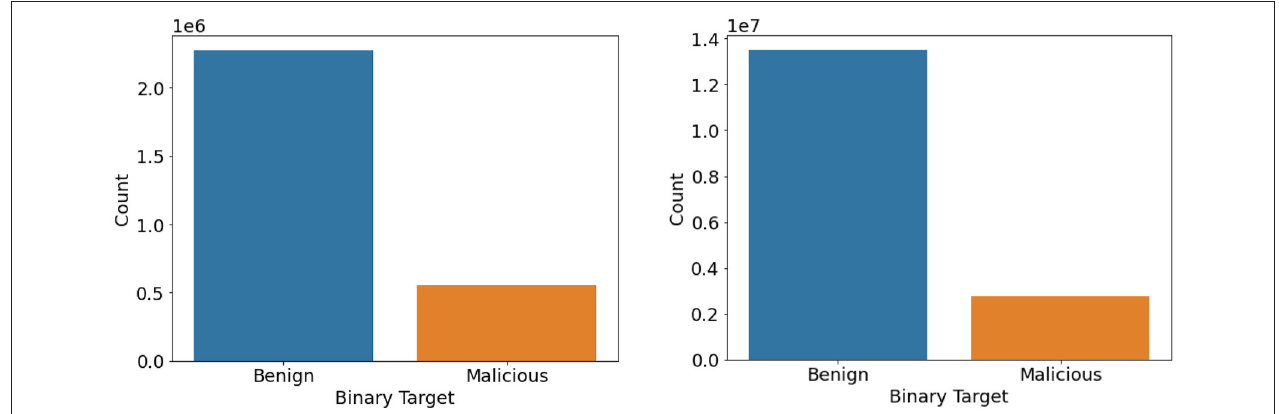
FIGURE 3 | Binary class count plot of CIC IDS 2017 (left) and 2018 (right)